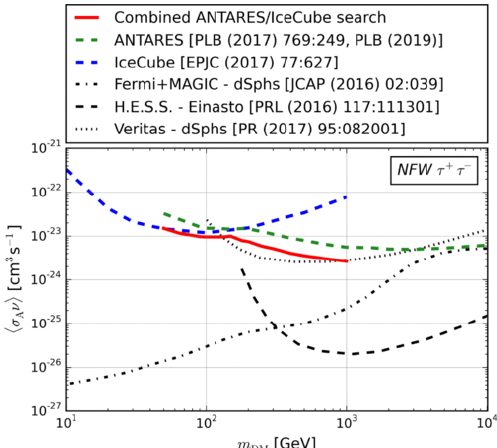
Figure 6. 90% CL upper limit on the thermally-averaged dark matter annihilation cross section < σ A v > obtained for the combined analysis as a function of the dark matter mass m DM assuming the NFW halo profile for the τ + τ − annihilation channel [53]. The limits from IceCube [98], ANTARES [52], VERITAS [100], Fermi+MAGIC [101] and H.E.S.S. [99] are also shown.